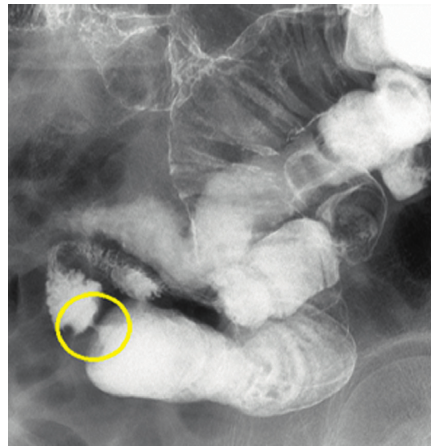
Figure 5: Small bowel enteroclysis. Stenosis was very severe, and the oral lumen was